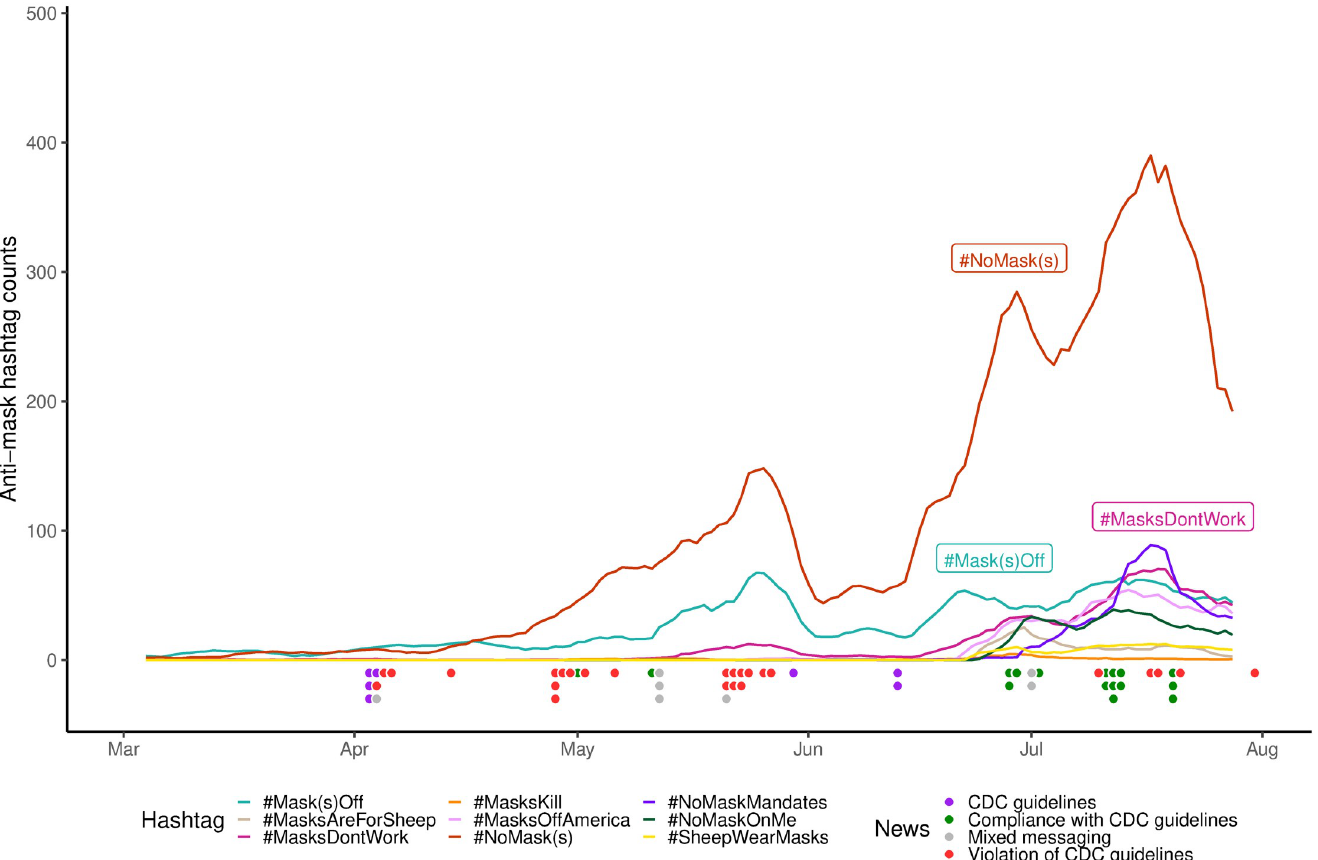
Fig 2. Trends of anti-mask hashtag uses on Twitter. This figure shows the 7-day moving averages of the daily rates of all anti-mask hashtags from early March to early August 2020. As Fig 1, along the timeline are shown media coverages on CDC recommendations and administrative actions related to masks.